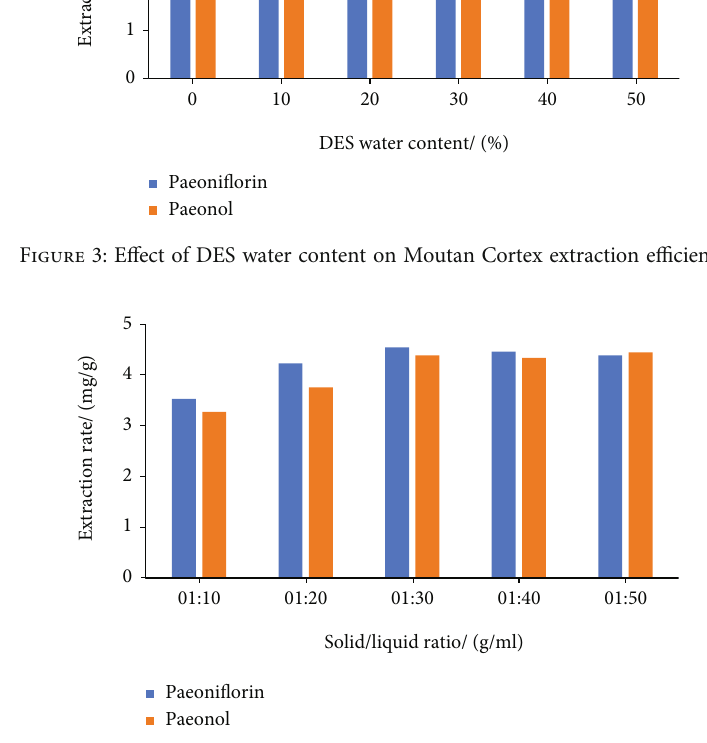
Figure 4: E ff ect of solid/liquid ratio on Moutan Cortex extraction e ffi